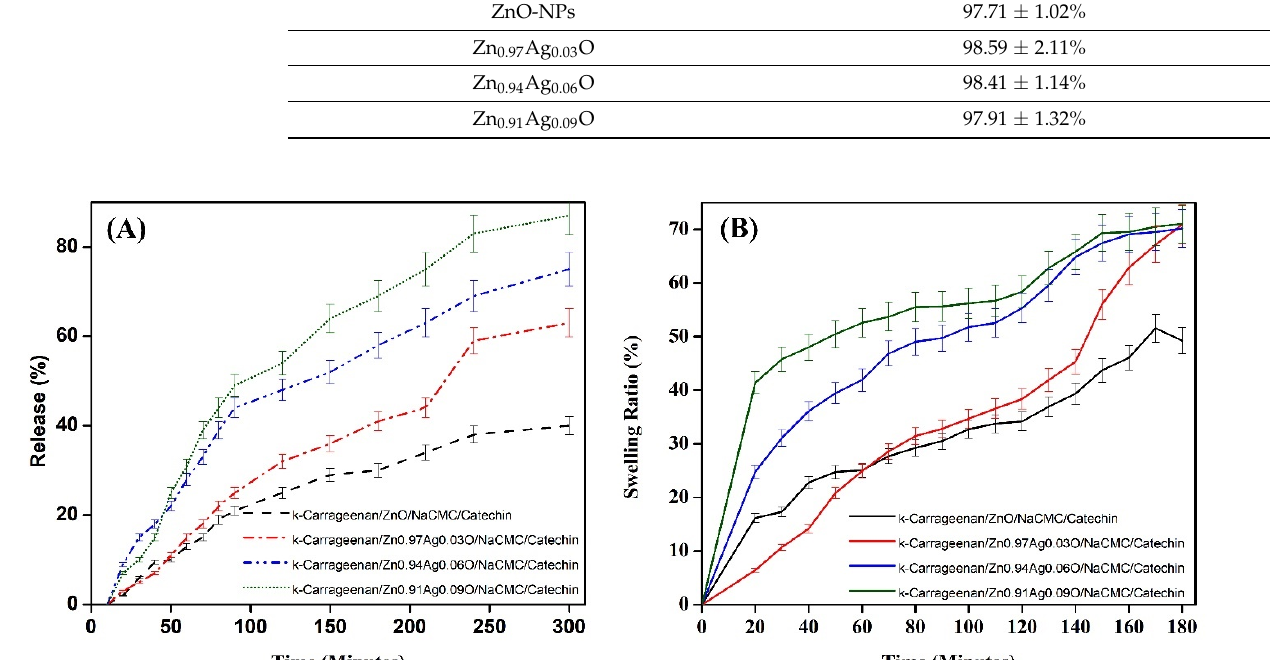
Figure 11. ( A ) Time-dependent in vitro release of catechin from ( B ) the swelling equilibrium of the hydrogels and ( B ) the time-dependent in vitro release of catechin from the hydrogels.